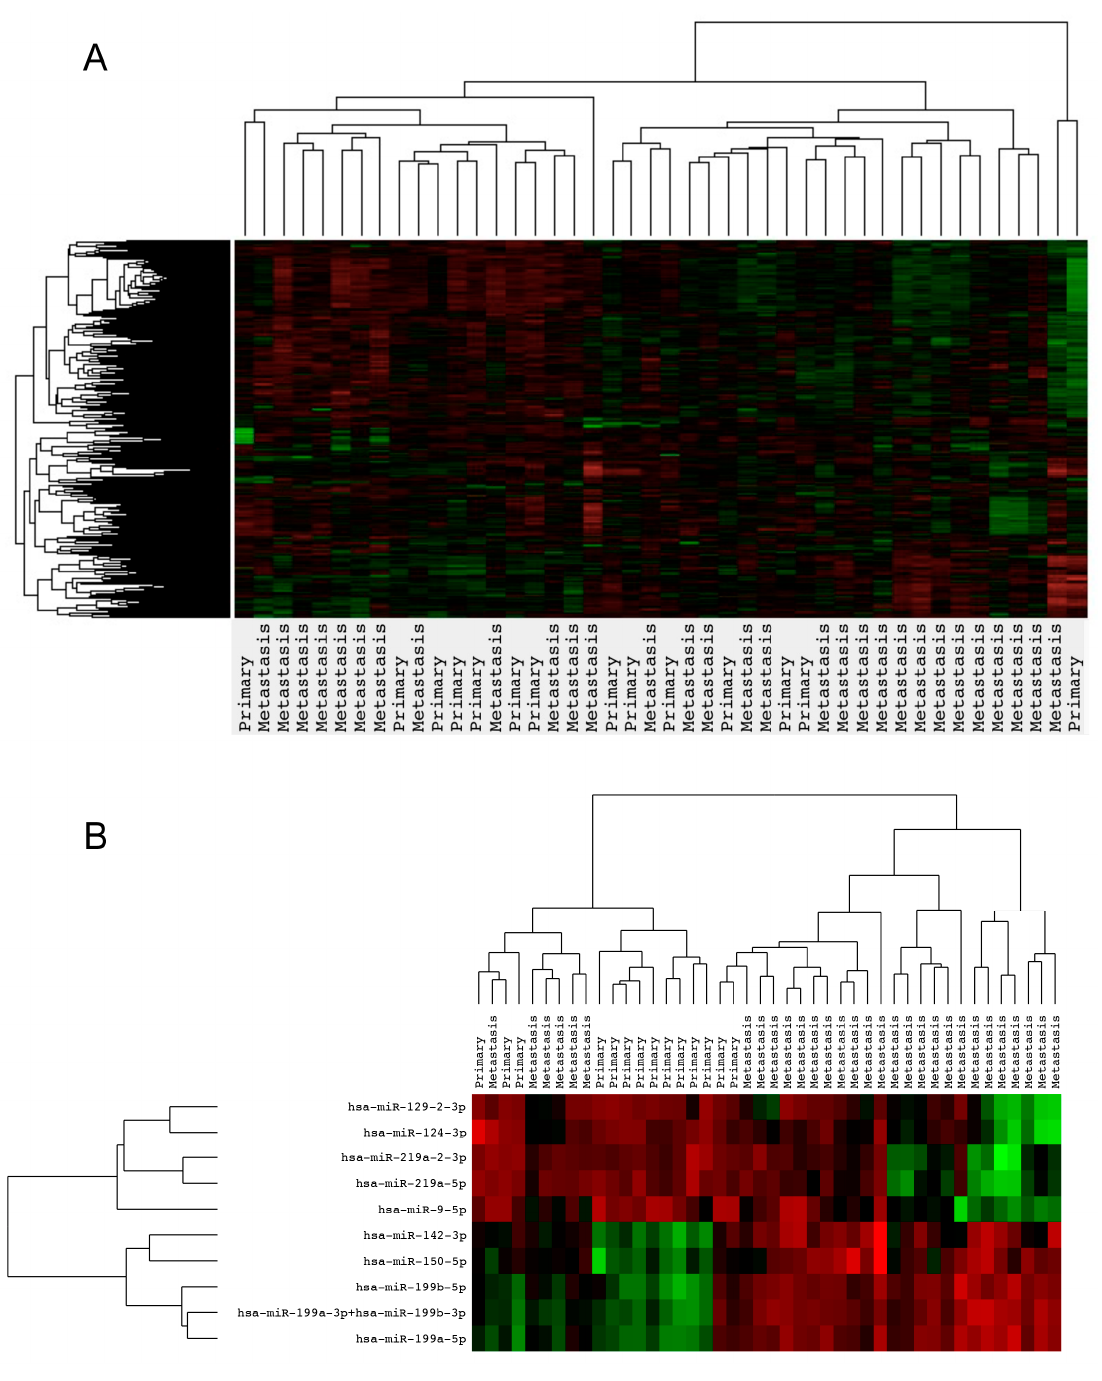
Figure 1. Hierarchical clustering of miRNAs in primary NSCLC versus brain metastasis. ( A ) Unsupervised hierarchical clustering of 827 human miRNAs in primary NSCLC versus brain metastatic lesions. ( B ) Clustering of differentially expressed miRNAs in primary NSCLC versus brain metastatic lesions. Rows display individual miRNAs; columns display sample source. Color scale is depicted from red to green. Red = low expression; green = high expression.